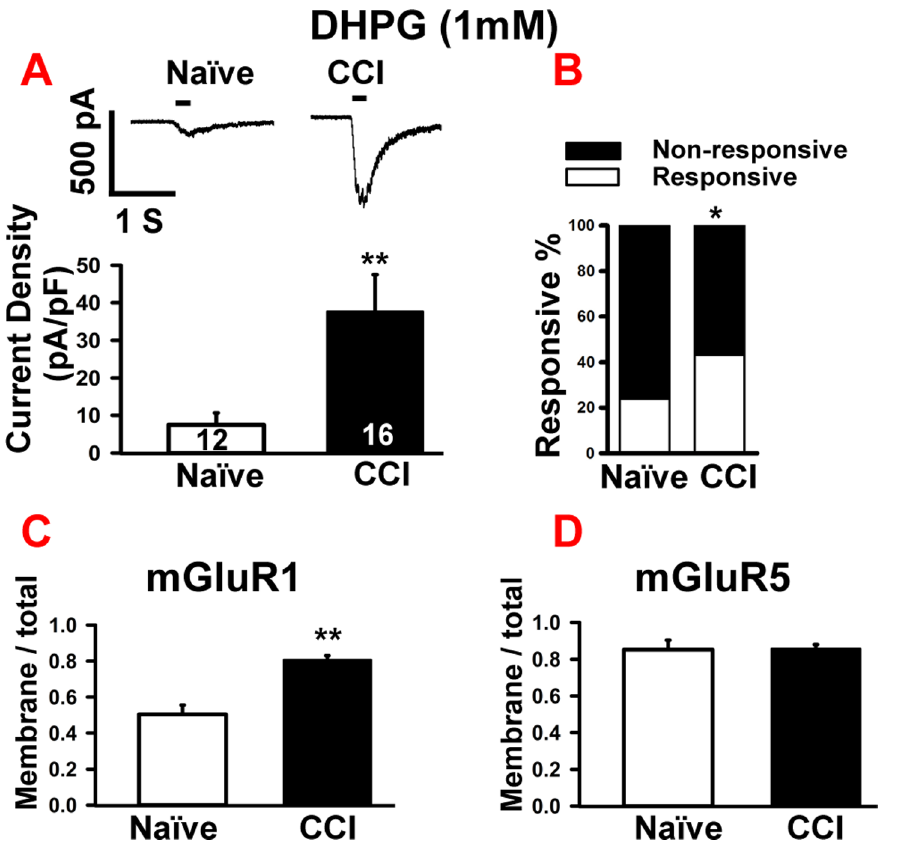
Figure 4. CCI of sciatic nerve increased responses to DHPG in small diameter neurons. A. Upper panel: Example of DHPG-induced (100 m M, 200 ms) increases in currents in CCI vs. naı¨ve DRGs. Bar indicates the duration of drug application. Lower panel: Statistical analysis showed that DHPG induced a much bigger response in CCI group compared with naı¨ve. B. Population analysis showed that the percentage of DHPG- responsive neurons increased after CCI. C. Western blot analysis showed increased mGluR1 expression (normalized membrane/normalized total protein) in naı¨ve and CCI DRGs. D. Western blot analysis showing that the expression of mGluR5 subunit in the membrane did not change significantly after CCI, compared to the naı¨ve group. Numbers in each column represents recorded neurons. Mean 6 SEM, * p , 0.05, **p ,